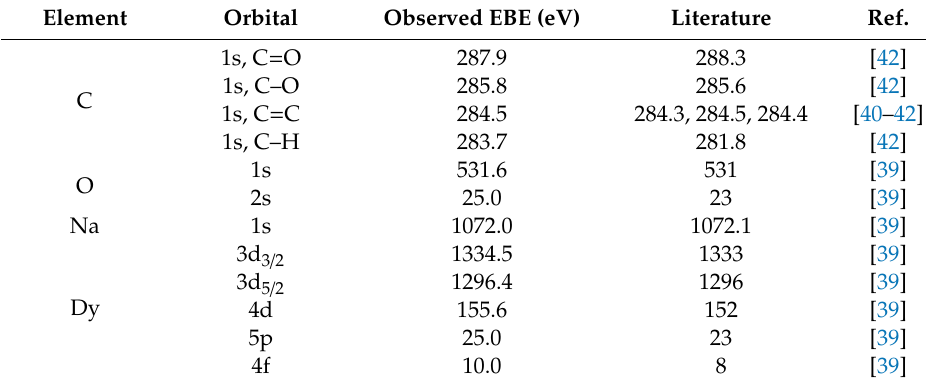
Figure 4. XPS spectra of DYO@C nanoparticles. ( a ) Whole range scan showing C, O, Na, and Dy elements in the nanoparticle sample and ( b ) carbon peak composed of four different carbons. Table 2. Electron binding energies (EBEs) of the elements observed in XPS spectra of the DYO@C nanoparticles.